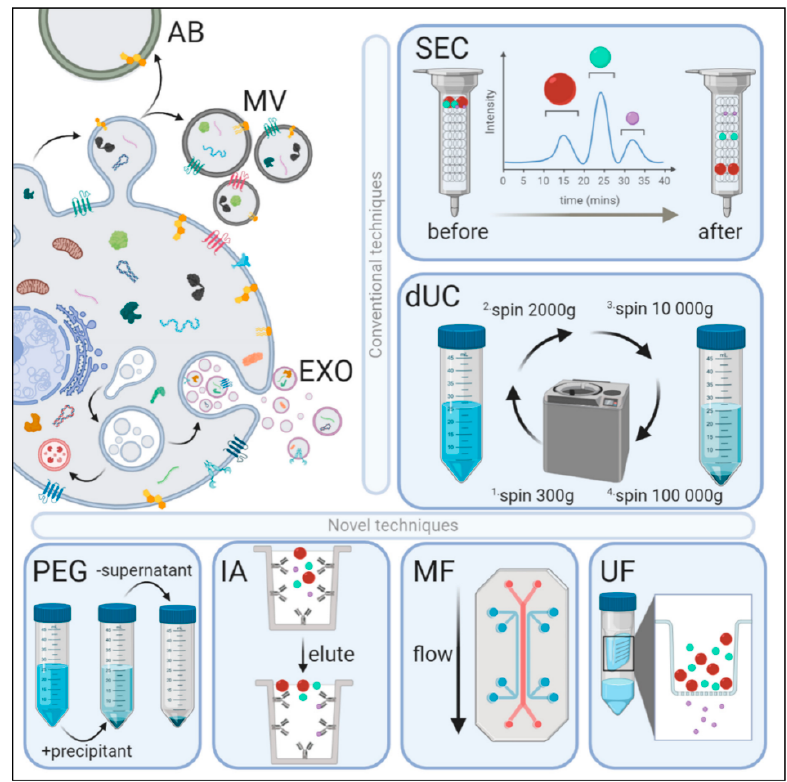
Figure 1. Extracellular vesicles (EVs) biogenesis and methods of isolation of exosomes. AB: Apop- totic bodies, microvesicles (MV), exosomes (EXO), size-exclusion chromatography (SEC) and differential ultracentrifugation (dUC), Poly-ethylene glycol (PEG), Microfluidics (MF) and Ultrafiltration (UF). Adapted under the terms and conditions of the Creative Commons Attribution (CC BY) license (http://creativecommons.org/licenses/by/4.0/) (Accessed on 02 March, 2021). [15].